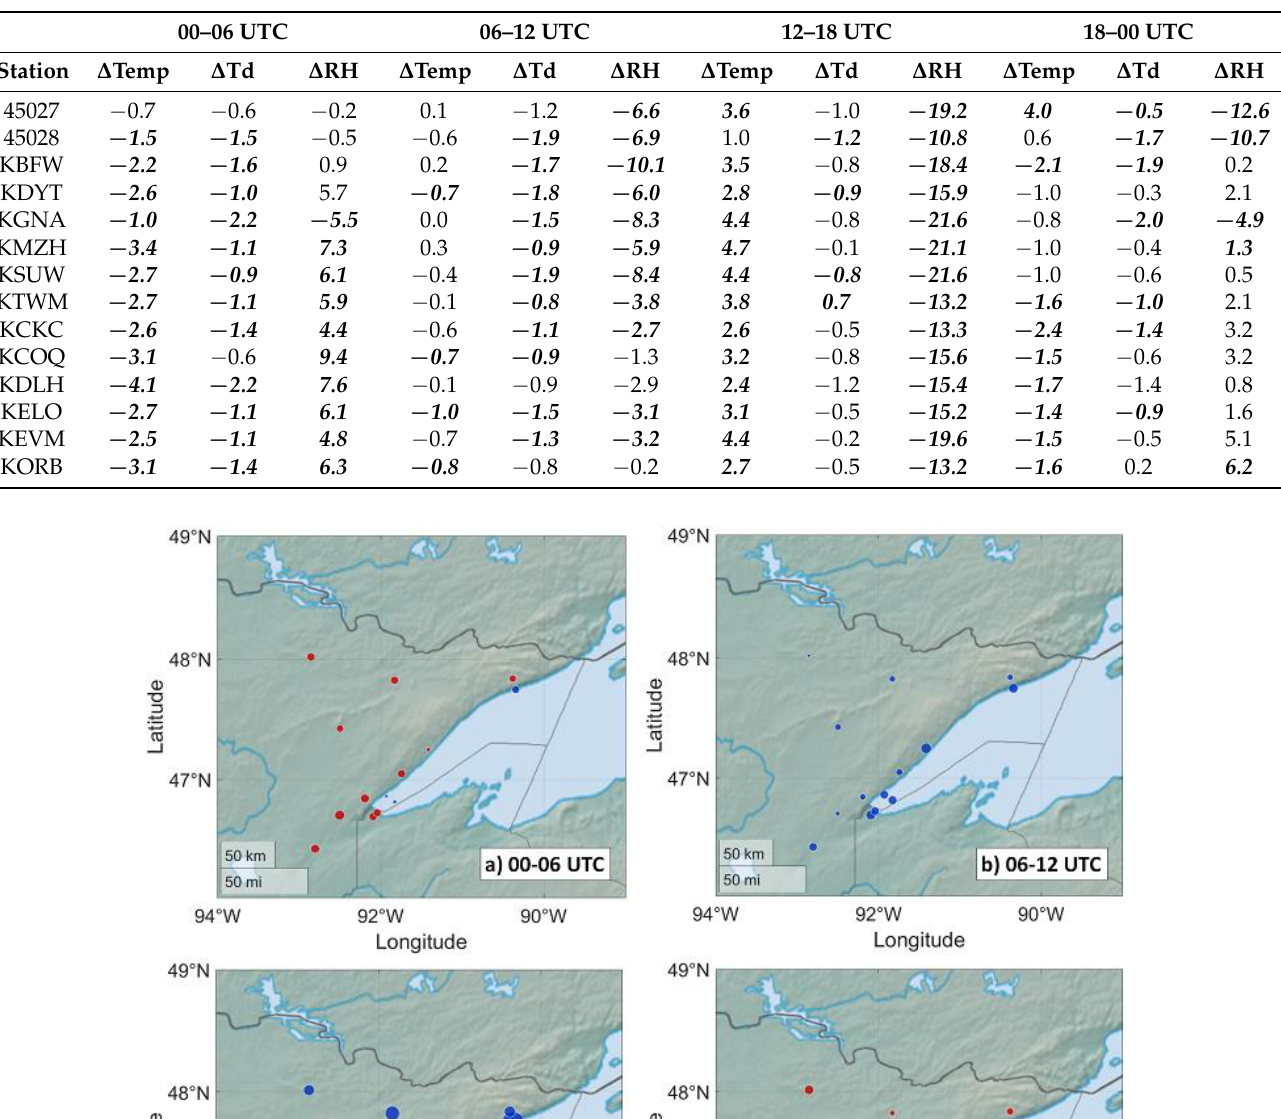
Table 6. As in Table 4 except for average temperature, dewpoint and relative humidity changes as a function of time of day. Values in bold/italics are significant at the 1% level, according to a Wilcoxon signed-rank test.